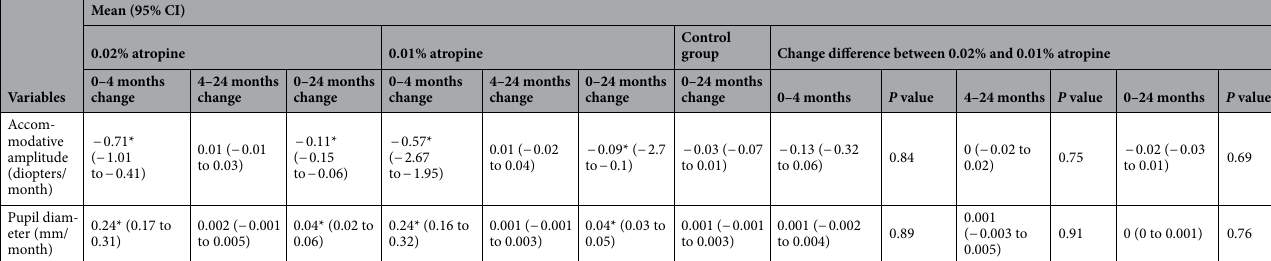
Table 3. Change and change difference of accommodative amplitude and pupil diameter in three groups over 2-year. CI: confidence interval. Change: represents the slope of accommodative amplitude and pupil diameter over time for three groups. Change difference: represents the difference in slope of accommodative amplitude (D/month) and pupil diameter (mm/month) over time between each two groups. A generalized additive mixed model was used to estimate the longitudinal trend. *Represents: changes were significantly